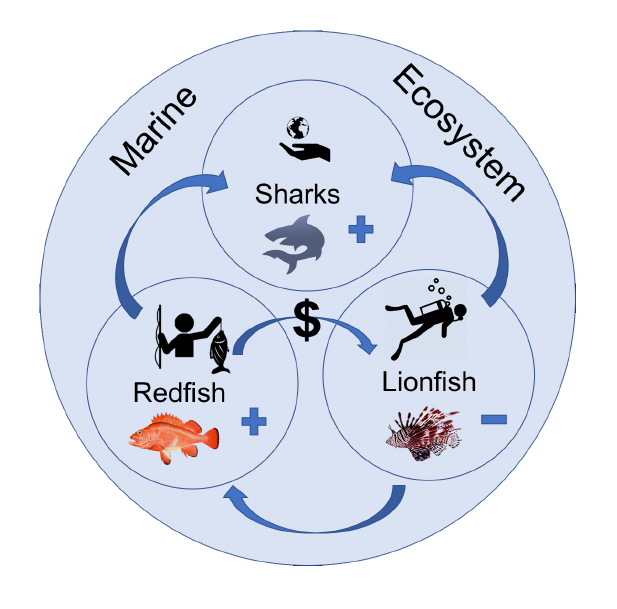
Fig. 1. Diagram of the interrelatedness of different perspectives within the Saba Island marine ecosystem (simplified